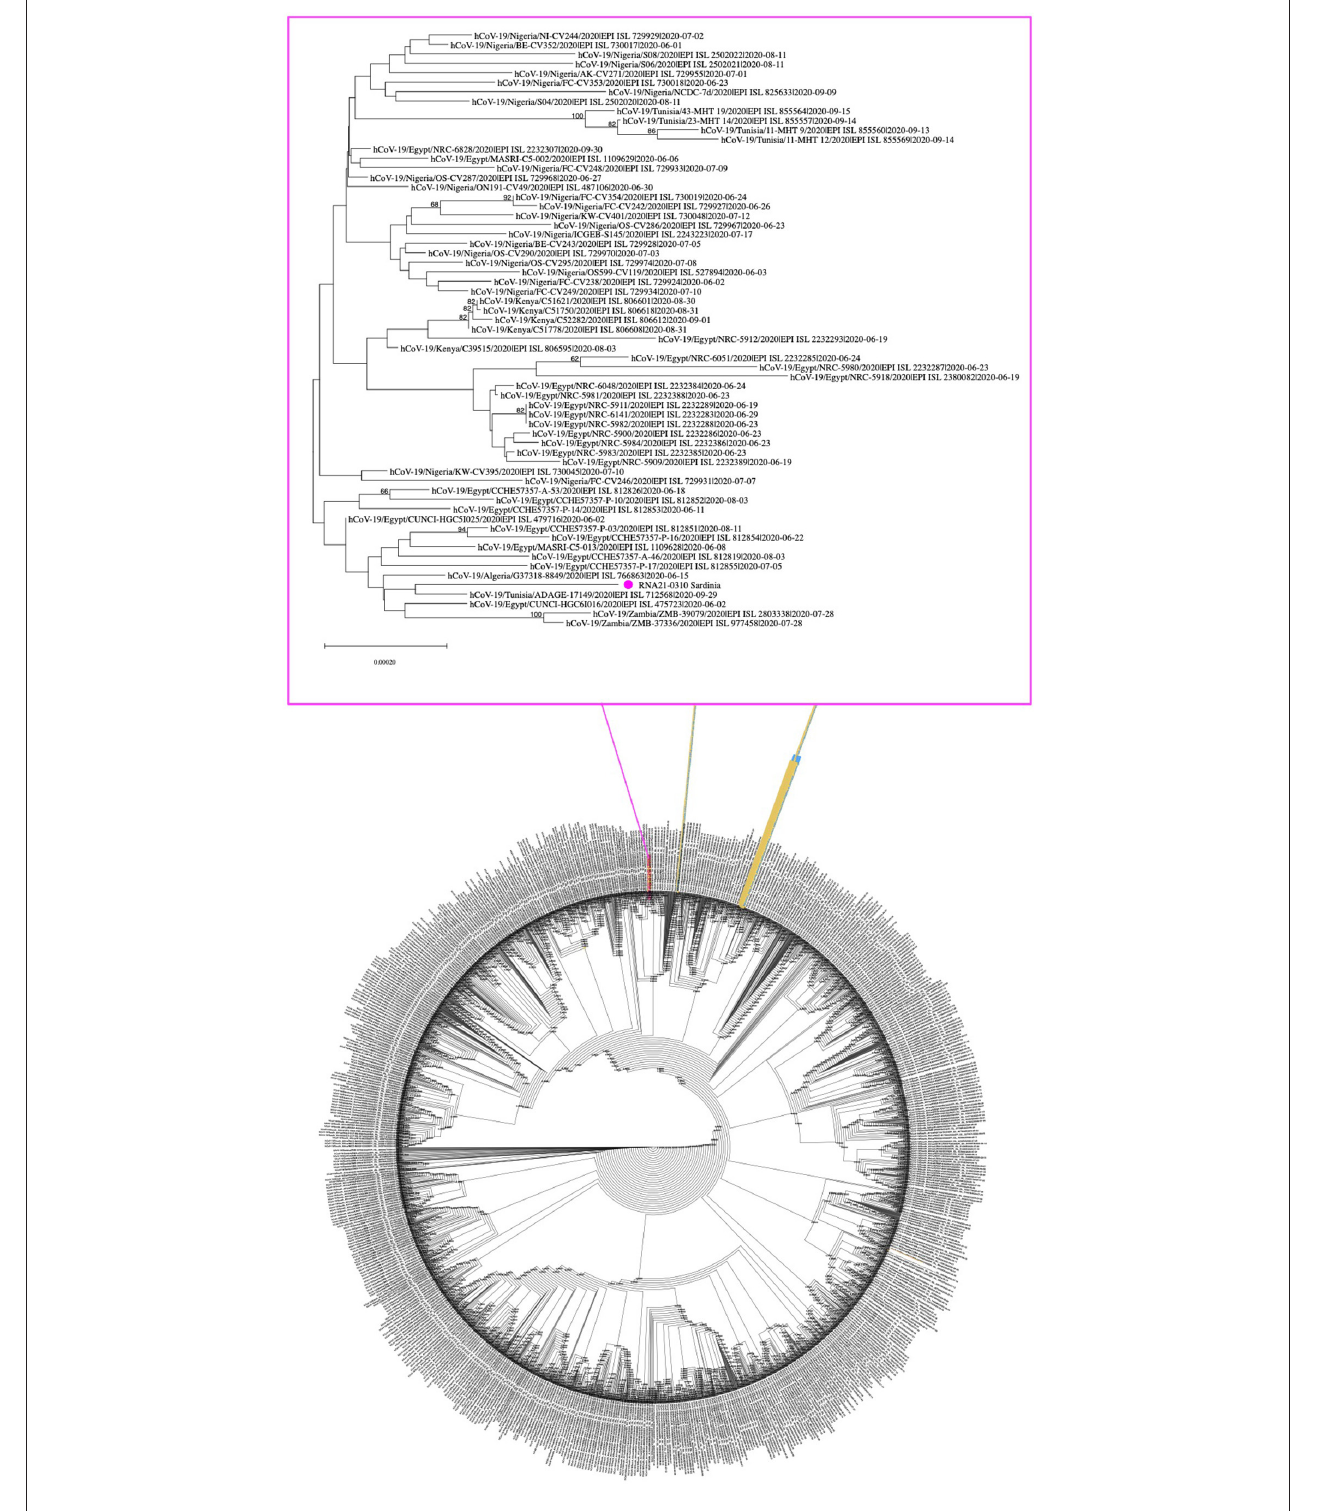
FIGURE 3 | Phylogenetic tree of SARS-CoV-2 genomes circulating in Africa during summer 2020. A total of 5,201 viral genomes collected in African countries between the beginning of June and the end of September 2020 were retrieved from GISAID and analyzed with the NJ method, applying the pairwise deletion option. Phylogenies were tested with 50 bootstrap replicates. The SARS-CoV-2 reference sequence (NC_045512) was also included. The IDs of the 310 sequence (NC_OL944327) from migrant and from (8) are included in yellow tags and highlighted in purple and blue, respectively.